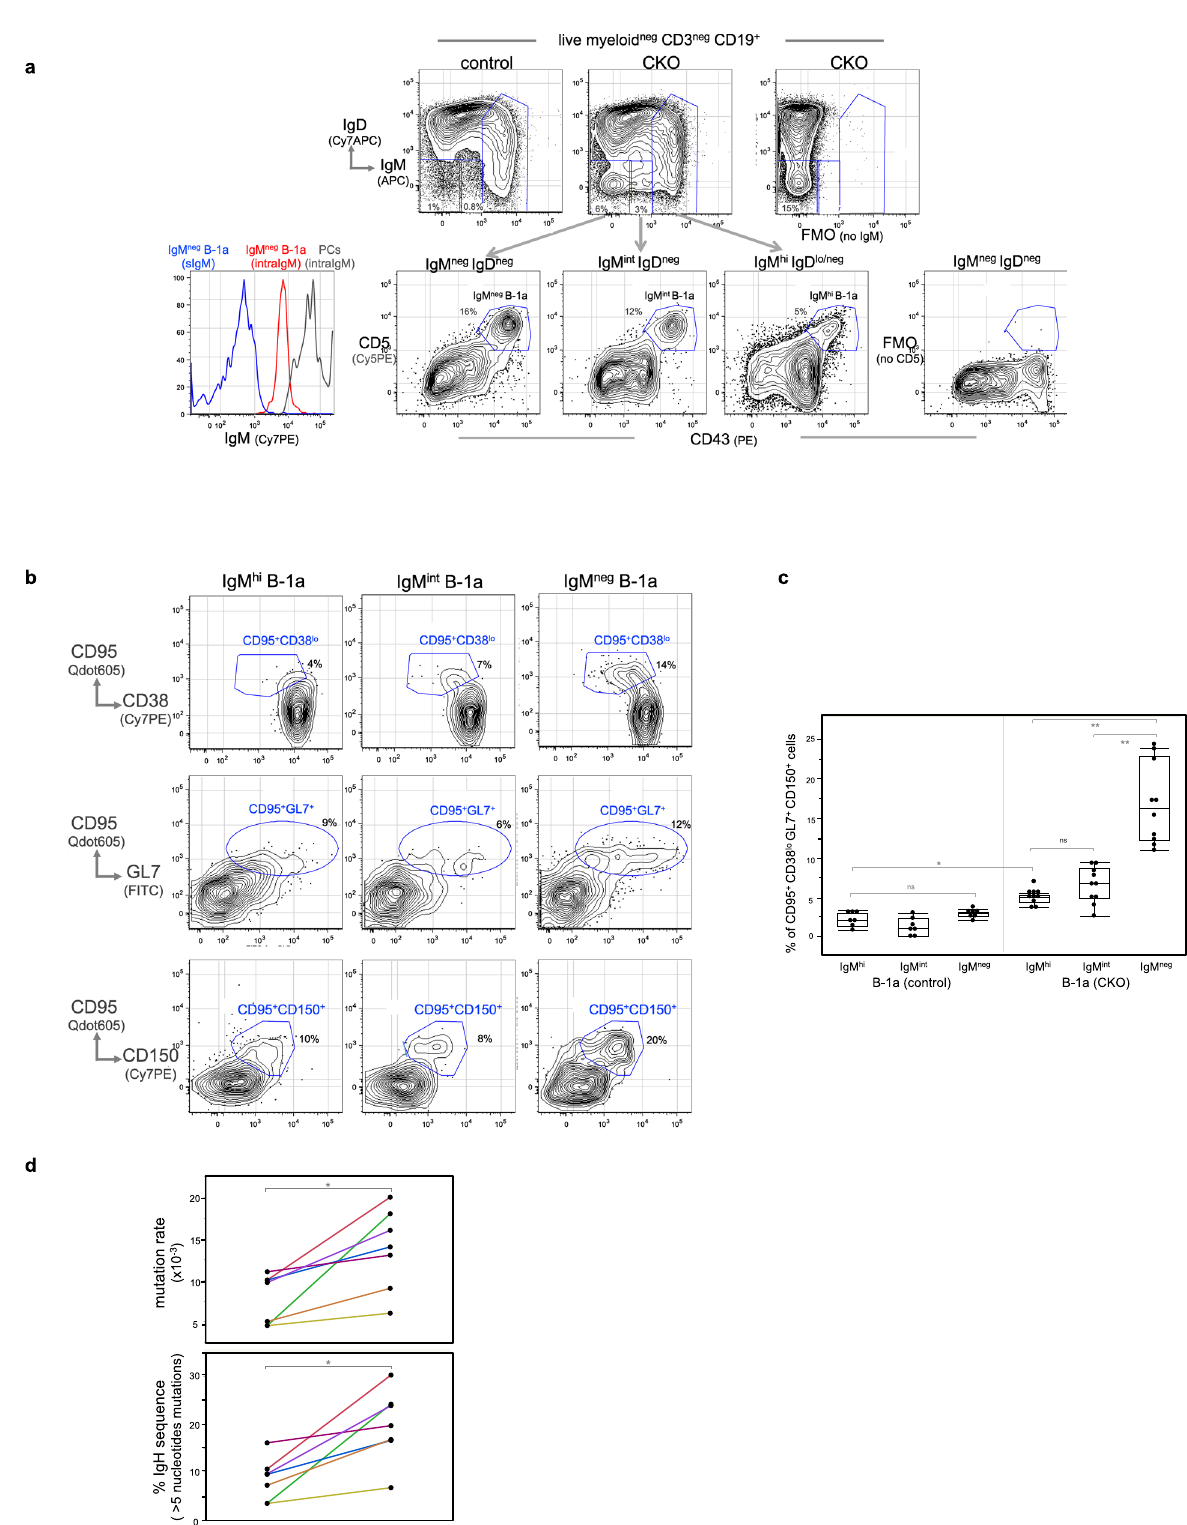
has a central role in antigenic loading of the MHC II molecule 46